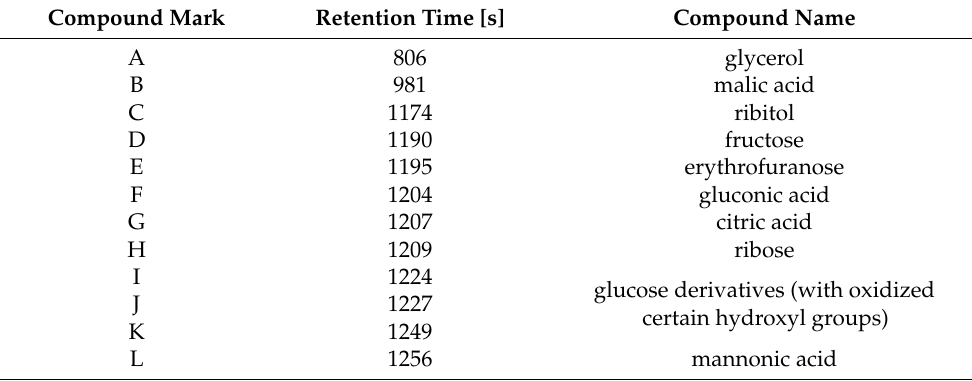
Figure 4. The chromatograms (ion current for m / z 73) of derivatized samples of tested extracts. The proposed identification of main components (marks with capital letters) was collected in Table 2. Table 2. The list of compounds with possible